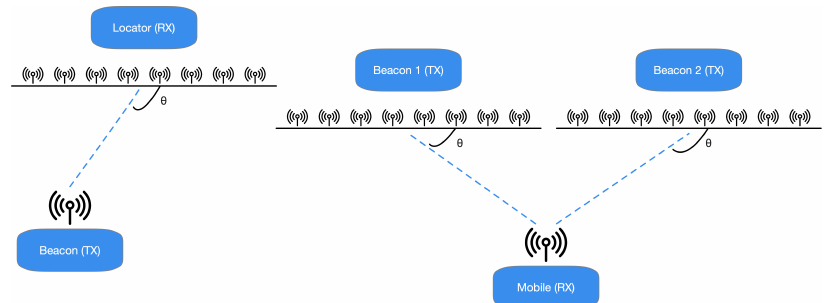
Figure 1. In the AoA radiogoniometry method (shown on the left ), the resources transmit their position to an AoA identifier that gauges the signal’s arrival angle. On the contrary, practicing the AoD method (depicted on the right ), beacons broadcast AoD data while a portable device collects the signals and estimates the point. Anyhow, the gathering device demands the computation capability to assess the place of the transmitter.